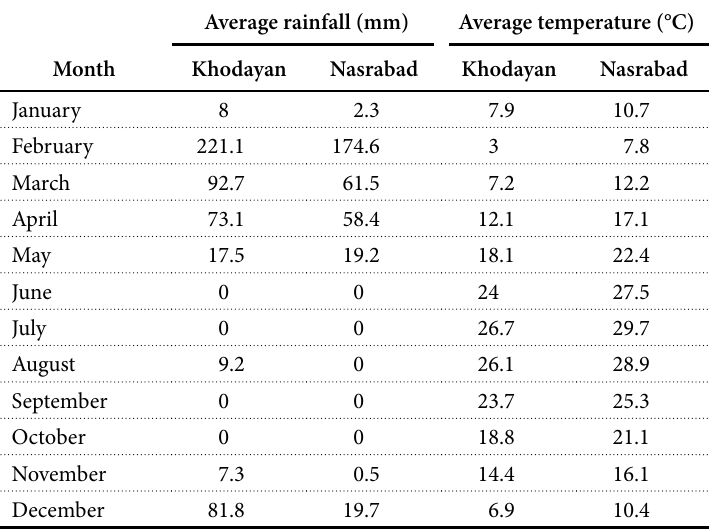
Tab. 2 Average monthly rainfall and temperature in the 2016 growing season for the two locations